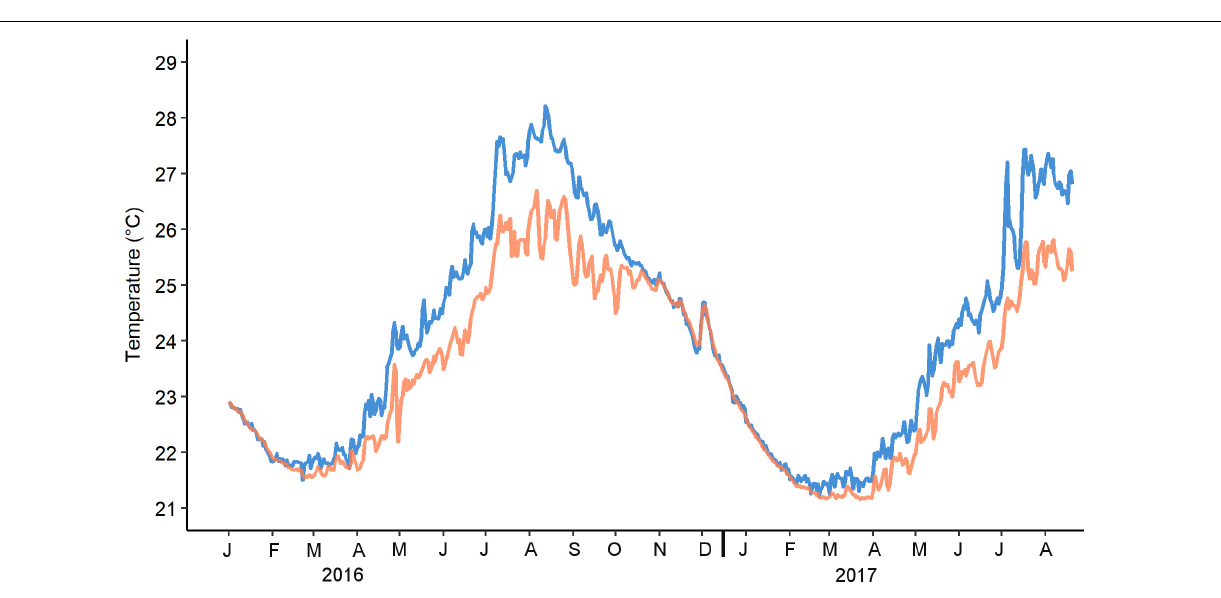
FIGURE 6 | Continuous average daily temperature measurements from shallow-water (blue) and upper mesophotic (orange)